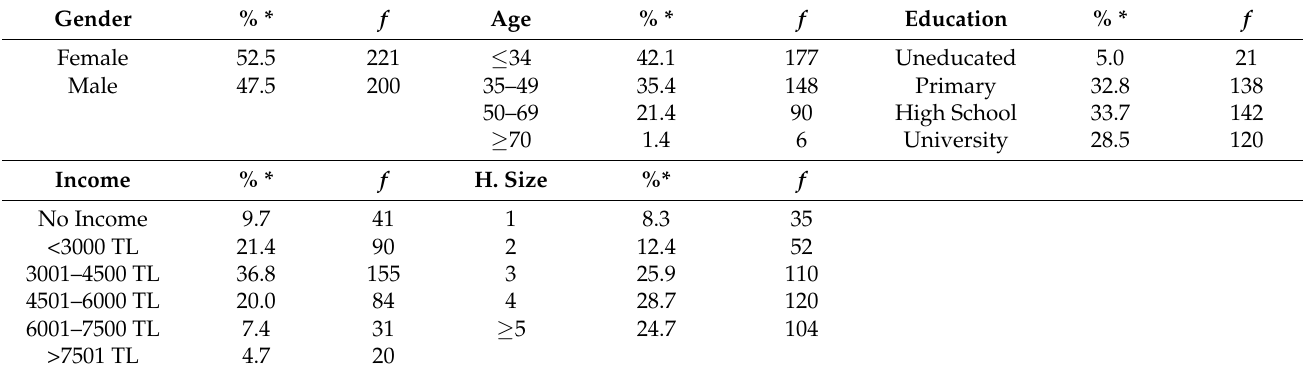
Table 1. Sociodemographic characteristics of the